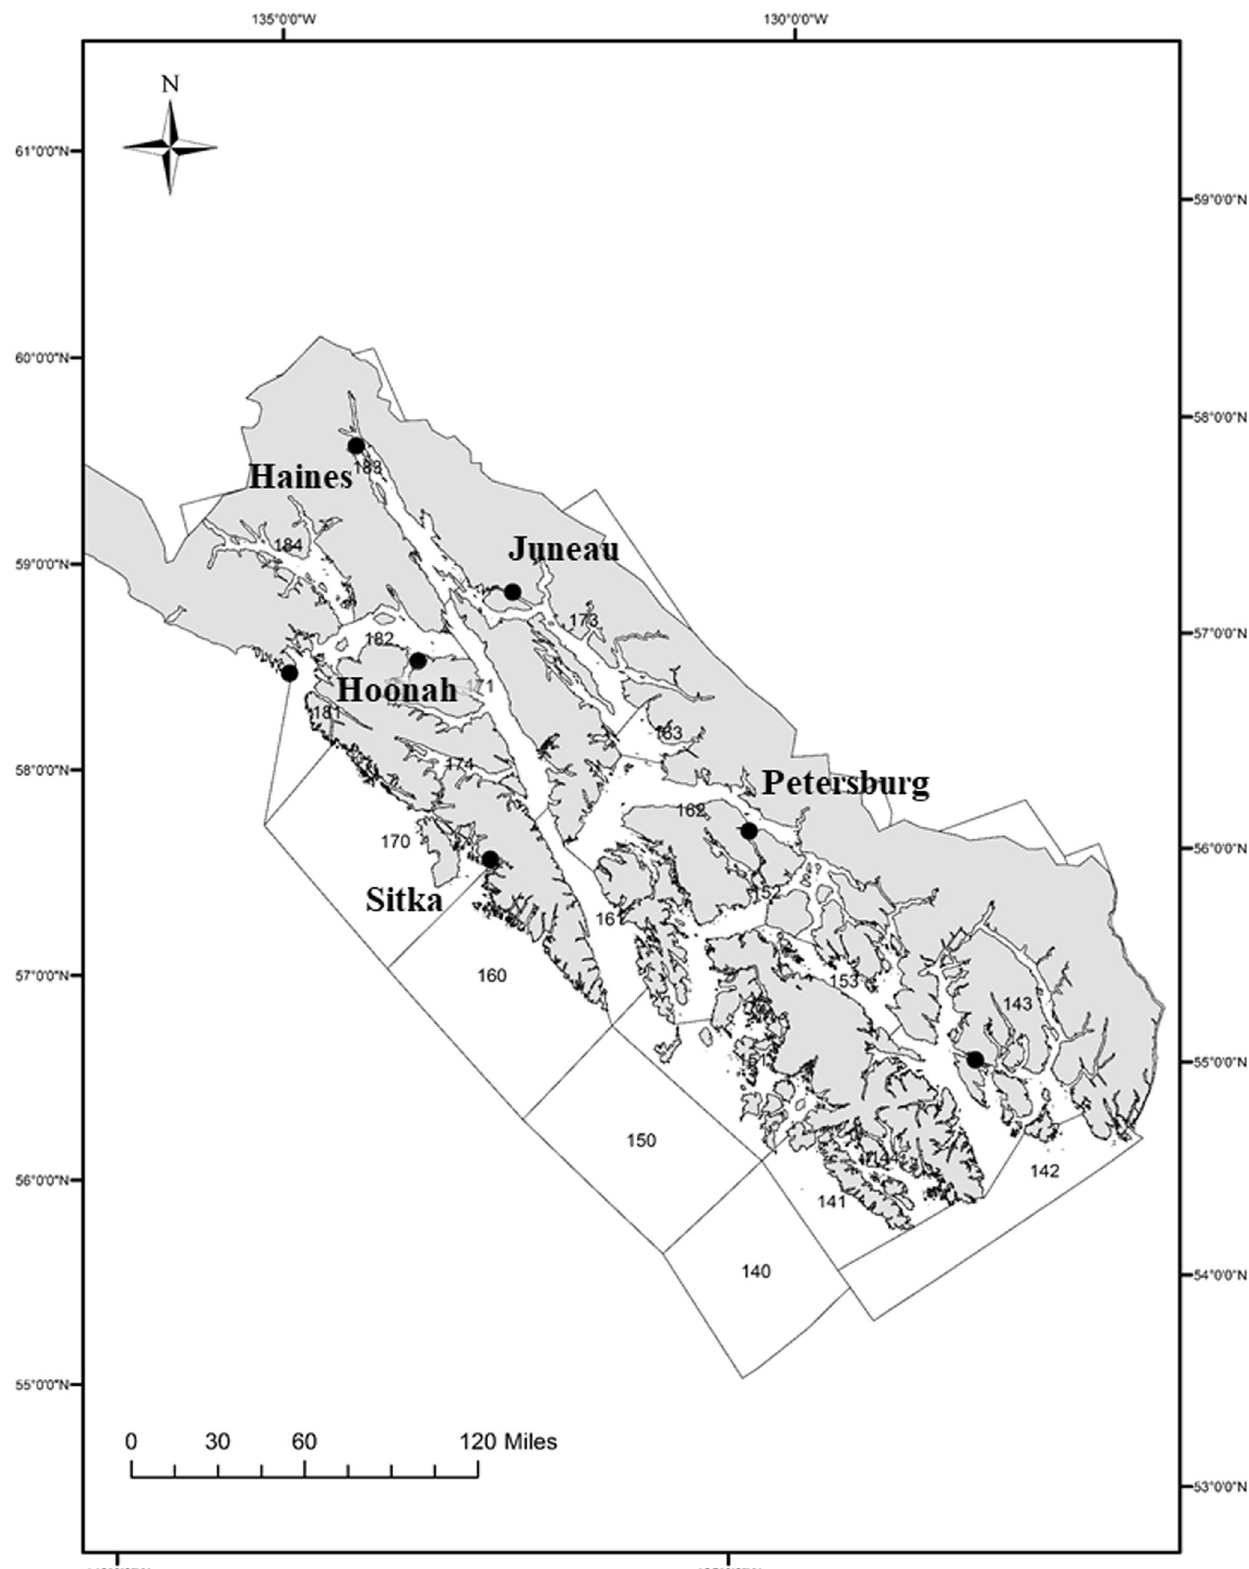
Fig 2. Map of regulatory area 2C, Southeast Alaska, with study communities labeled (created by the corresponding author).